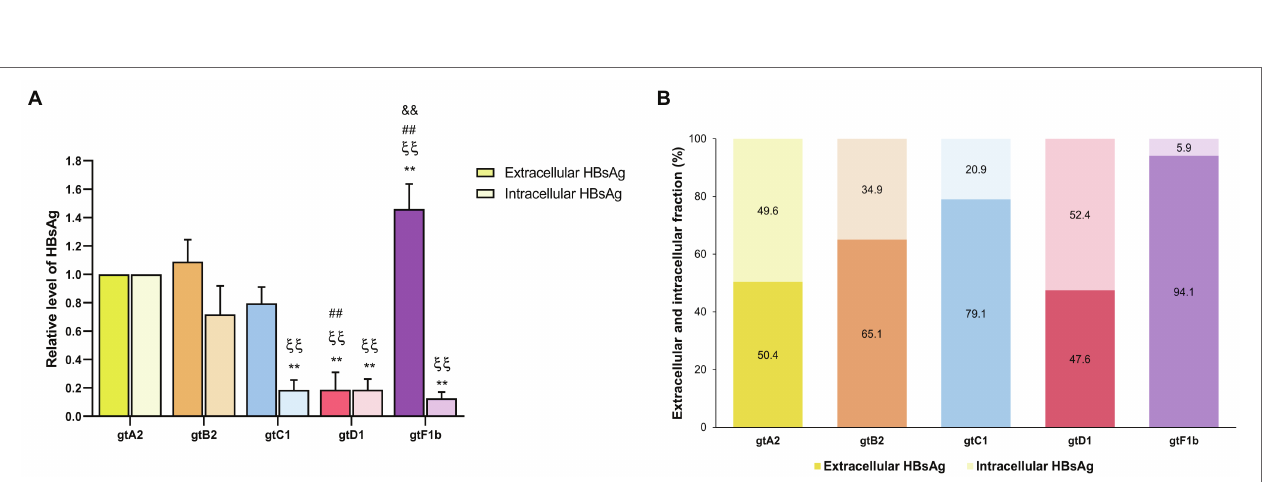
FIGURE 4 | Analysis of intracellular and secreted HBsAg levels across genotypes. HuH-7 cells were transfected with linear full-length HBV genomes of genotypes A2, B2, C1, D1, and F1b. Three days post-transfection, cells and culture supernatants were harvested, and intracellular and extracellular levels of HBsAg were determined by electrochemiluminescence immunoassay (A) . Extracellular/intracellular HbsAg ratio (B) . Values shown represent the mean ± standard deviation of three independent experiments. *: Intracellular or extracellular difference in relation to genotype A2, ξ : Intracellular or extracellular difference in relation to genotype B2, #: Intracellular or extracellular difference in relation to genotype gtC1 and &: Intracellular or extracellular difference in relation to genotype D1. Two symbols: p <